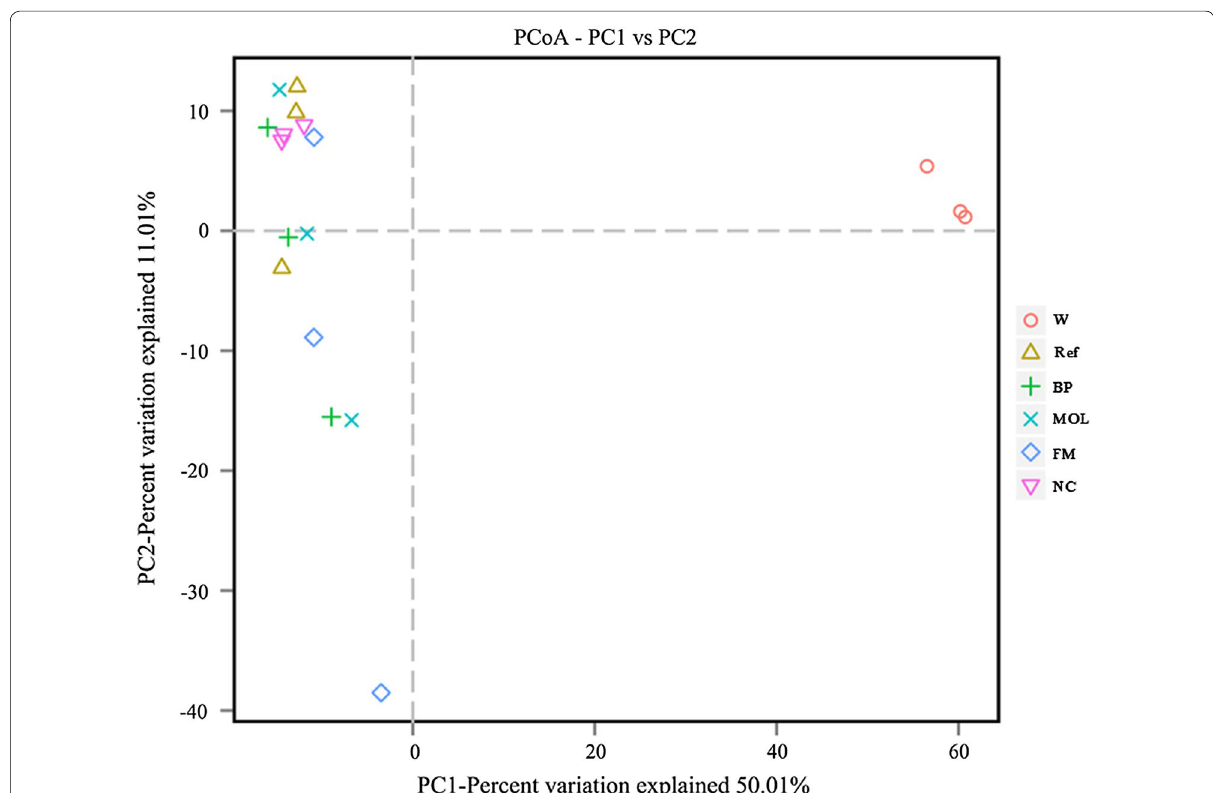
Fig. 4 PCoA analyzed the bacteria community. The colored circles represented the bacteria from W, Ref, BP, NC, MOL and FM. PCoA analyzed by with binary Jaccard